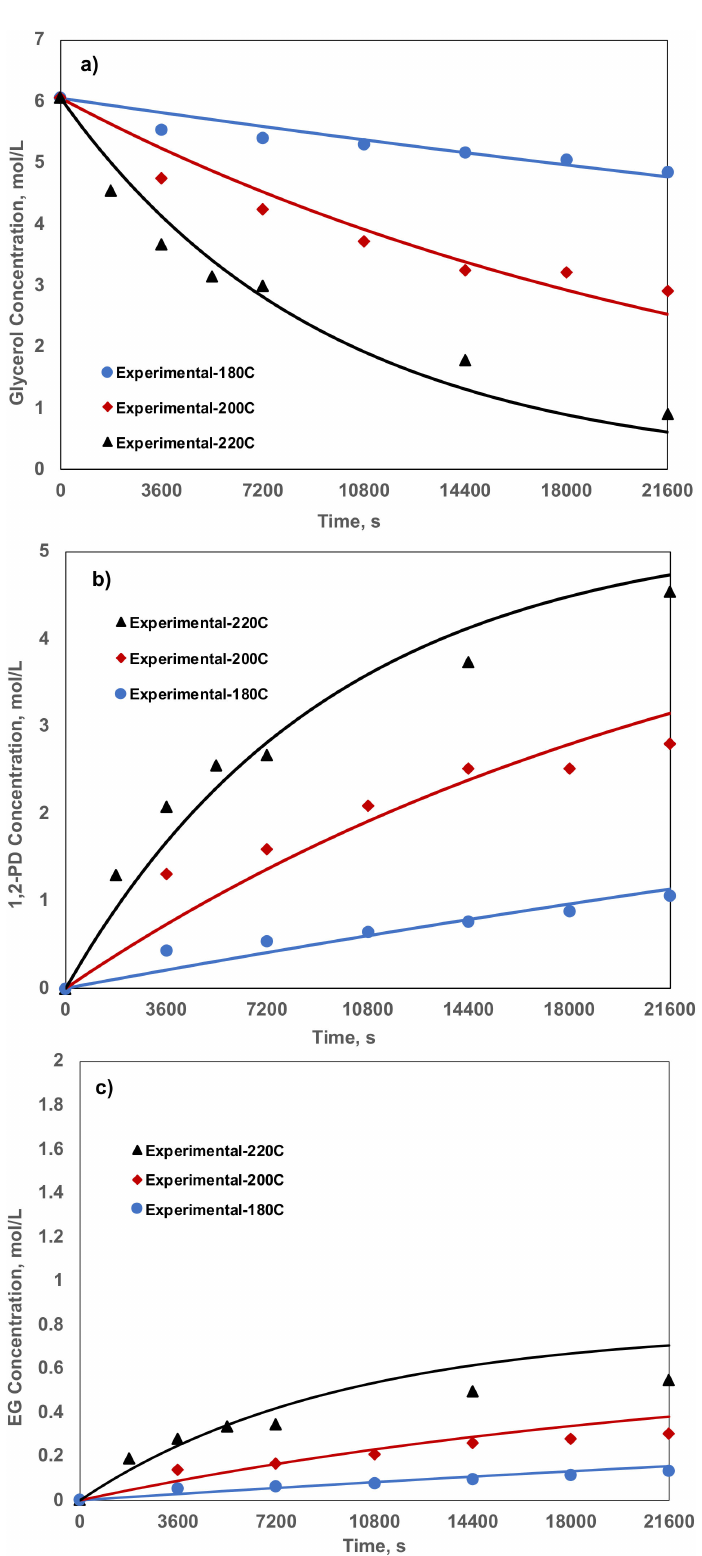
Figure A5. Concentration of each component over the reaction time of glycerol hydrogenaolysis at different temperatures: ( a ) Glycerol, ( b ) 1,2-PD, ( c ) EG. Lines: Predicted value from fitting